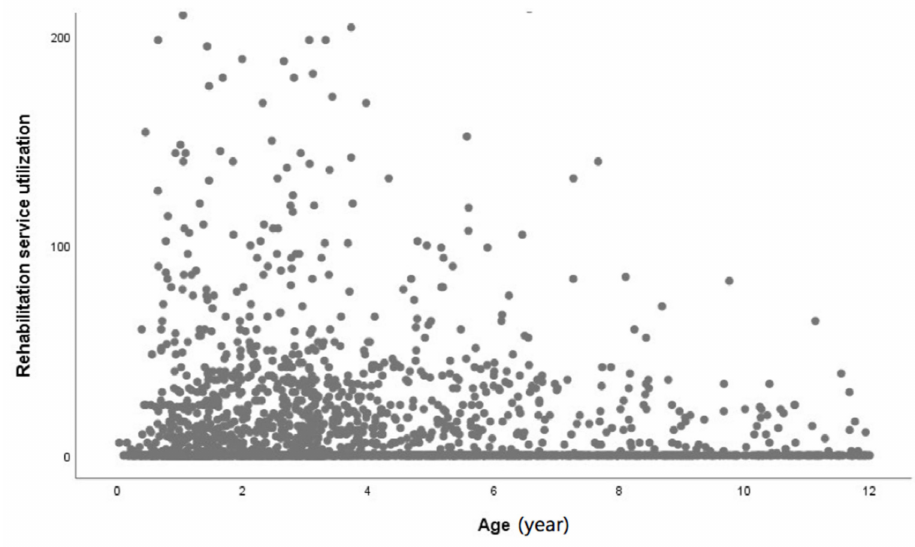
Figure 3. The presented rehabilitation utilization service among moderate to severe CP children. There is a trend that younger severe CP patients have higher rehabilitation service utilization than older